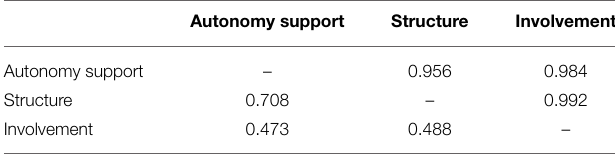
TABLE 3 | Latent factor correlations between the subdimensions in the